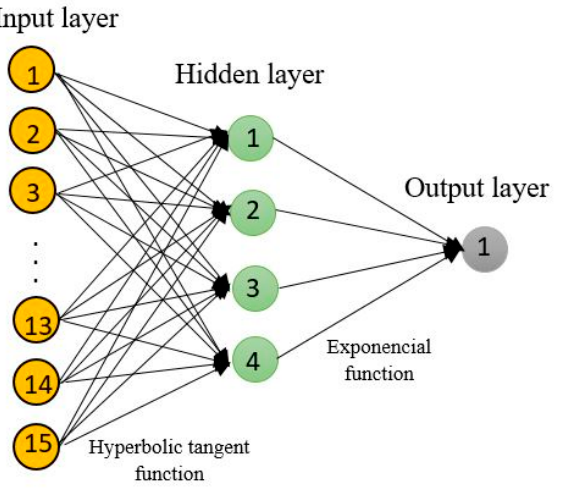
Figure 9. Structure of the best ANN MLP 15-4-1. Source: Authors.